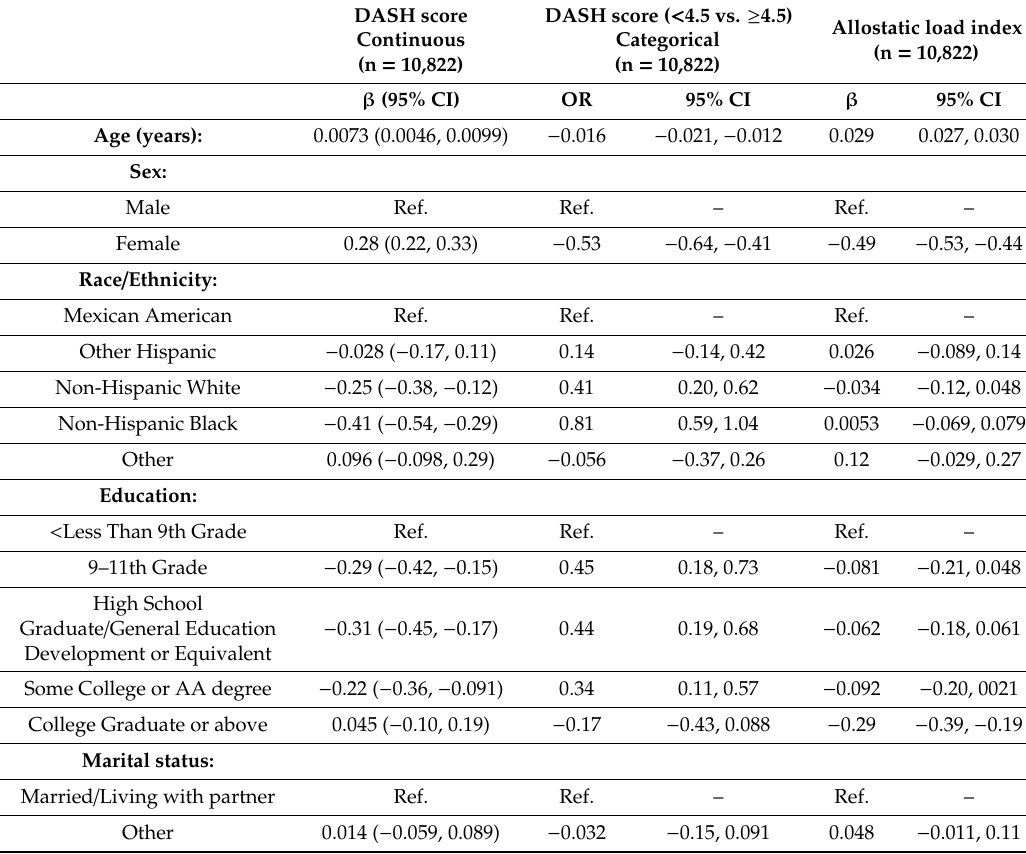
Table 3. Dietary Approaches to Stop Hypertension Diet Score and Allostatic Load Index Score by Demographic, Socioeconomic, Lifestyle, and Health Characteristics—2001–2010 NHANES (n = 10,822)